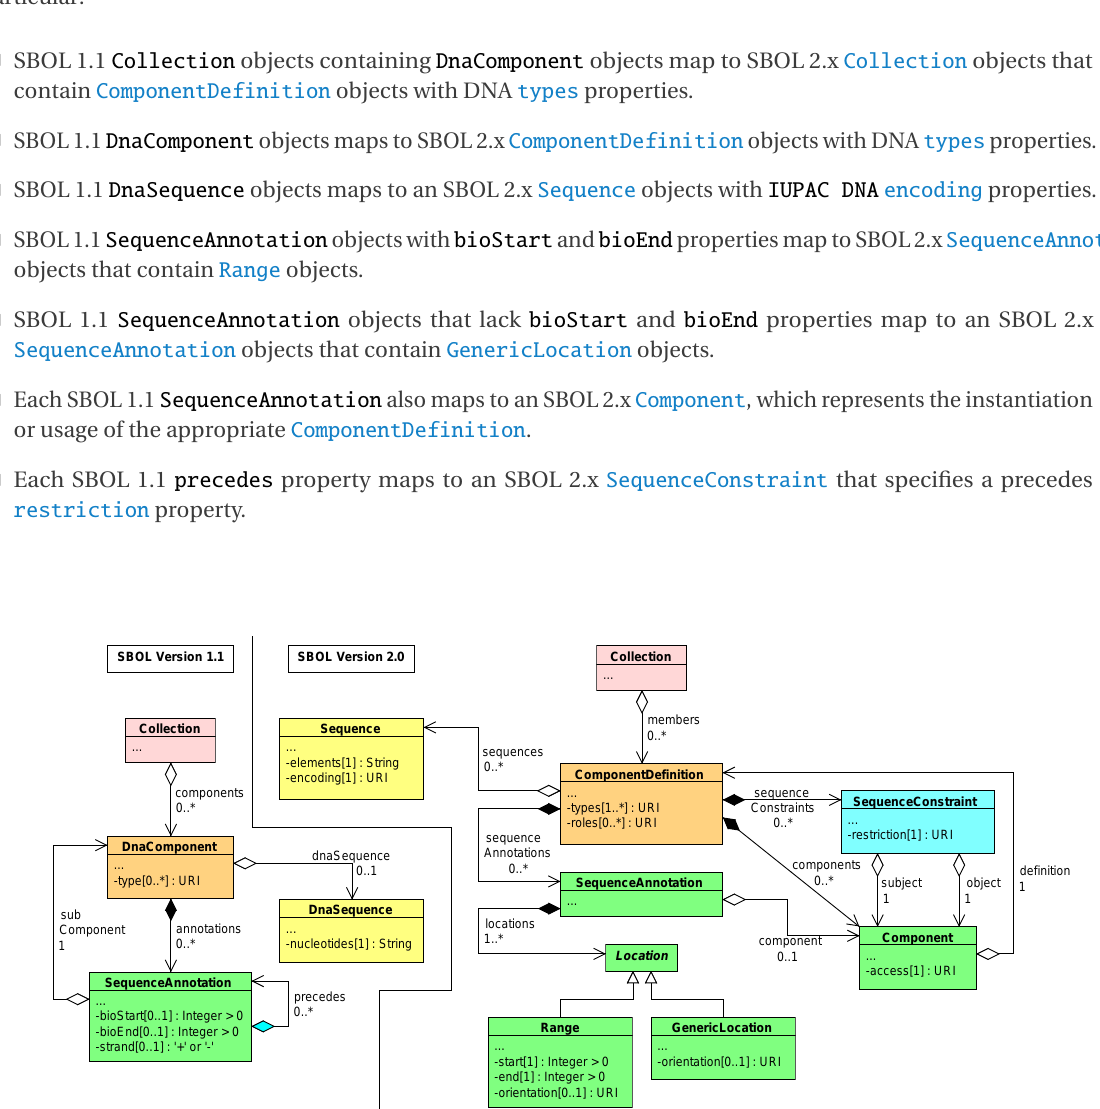
Figure 26 depicts the mapping of SBOL 1.1 classes to SBOL 2.x classes, indicating corresponding classes/properties